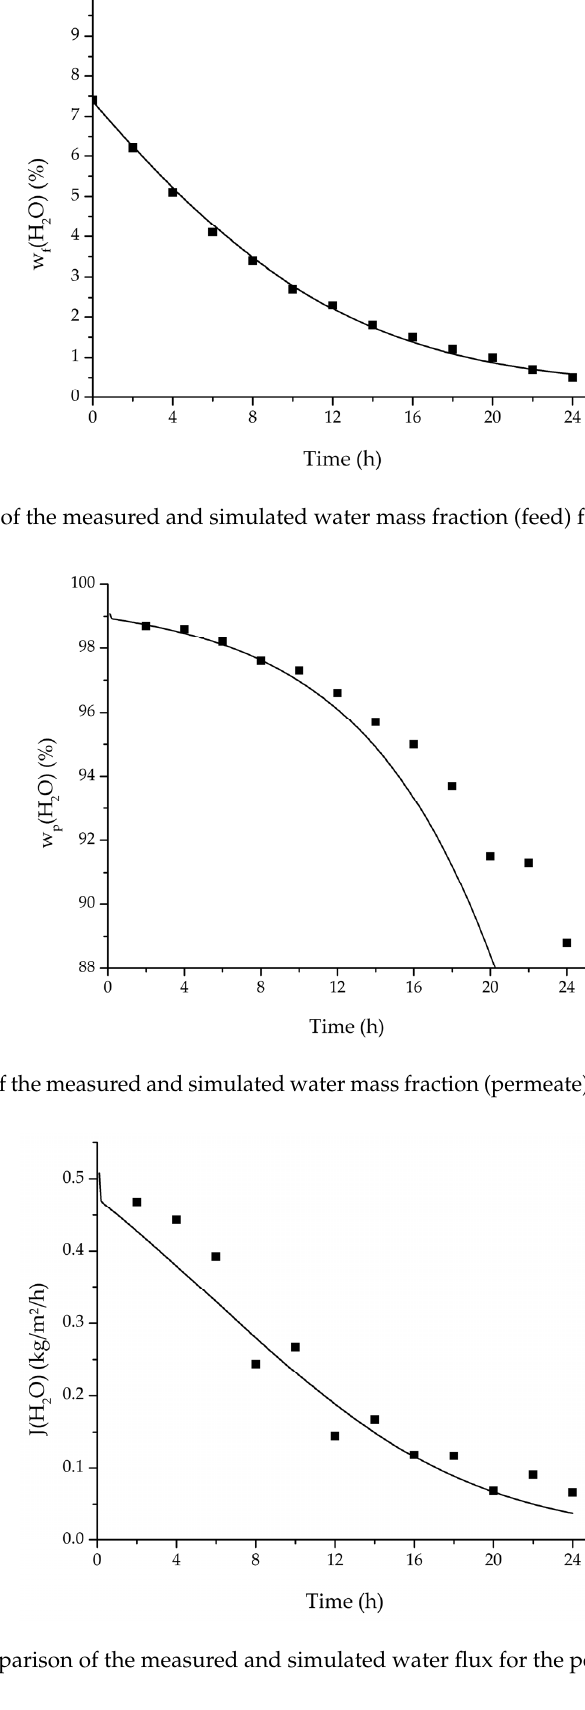
Figure 17. Comparison of the feed water content for the ternary system at 75 °C and 95 °C feed temperature.